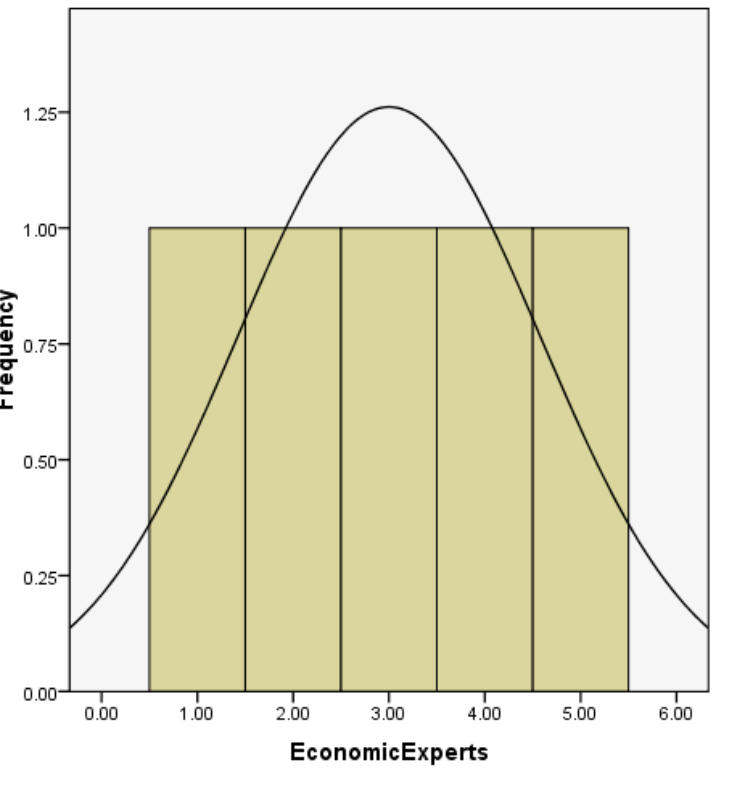
Figure 3. Economic Impact of